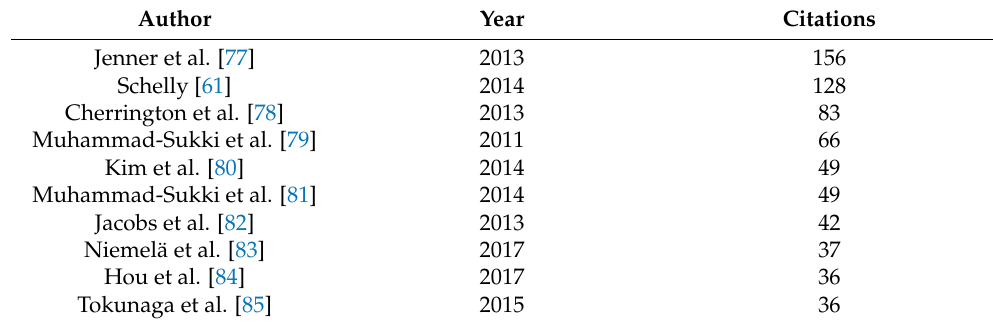
Table 10. Most Cited Papers (ROI).